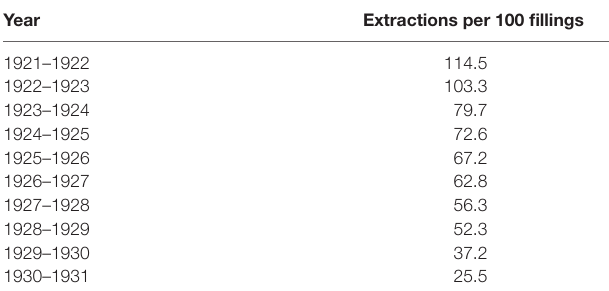
TABLe 1 | Number of extractions per 100 fillings (1921–1931)